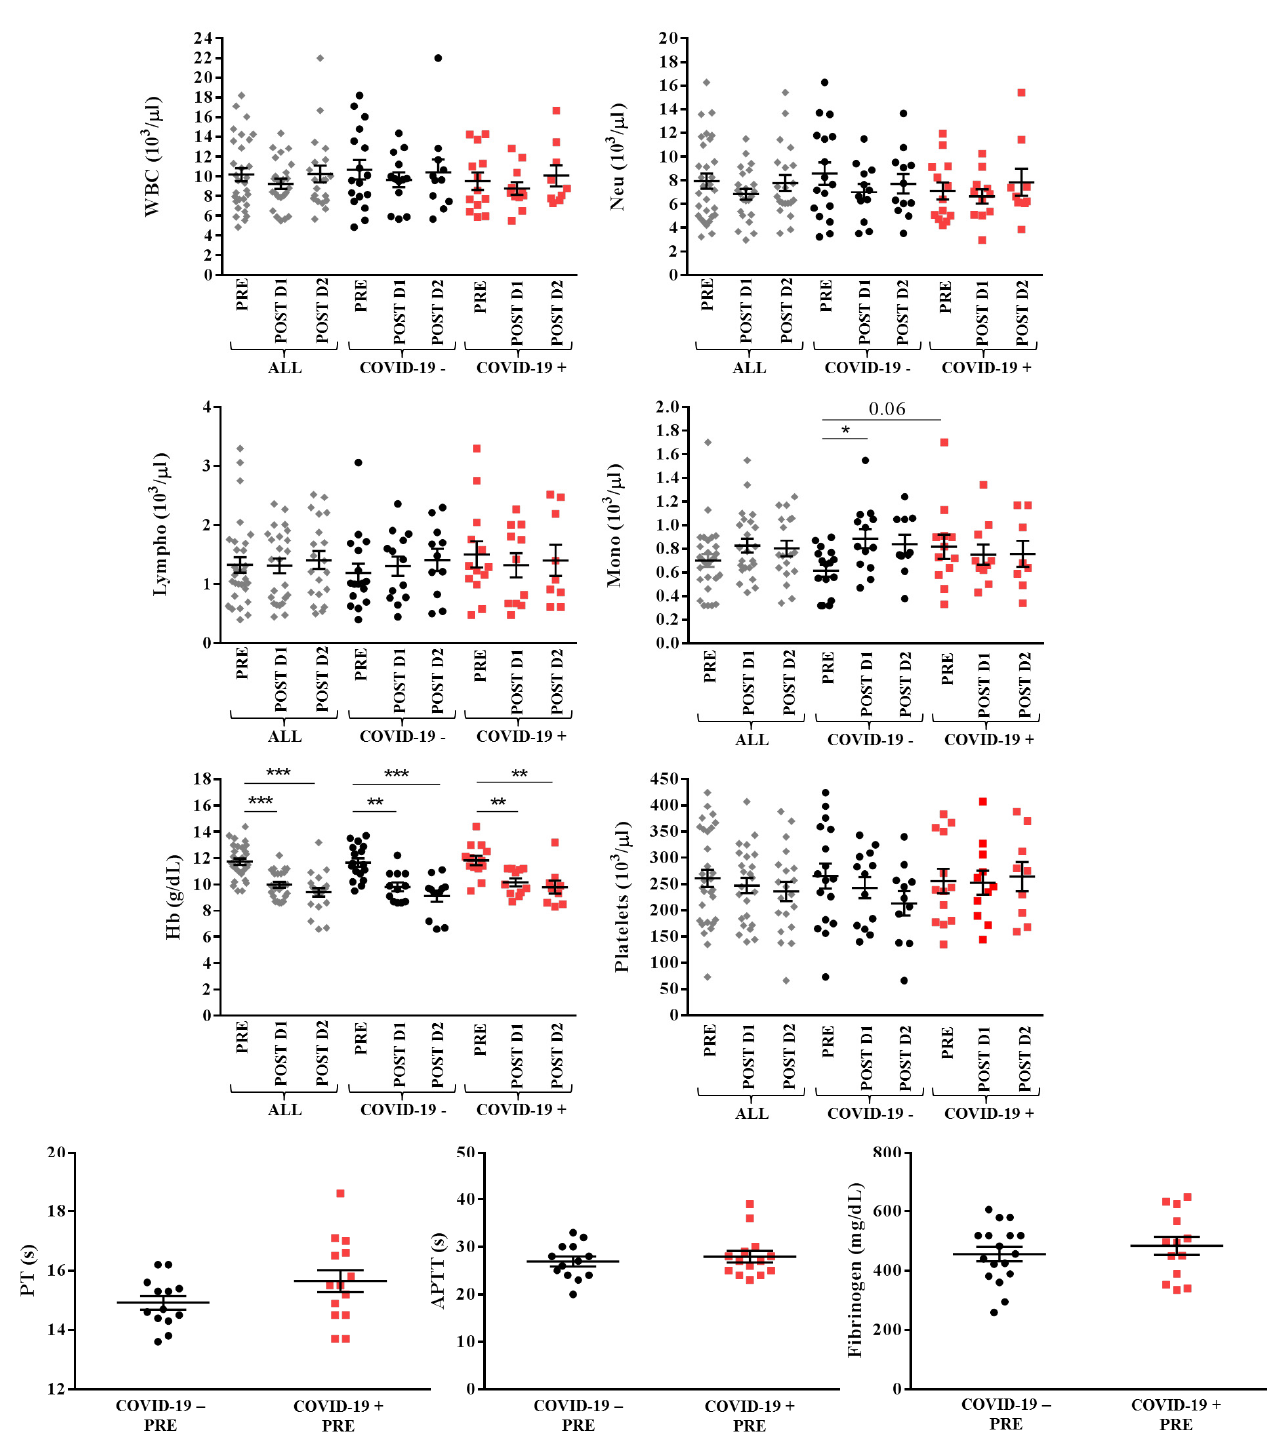
Figure 1. Hematological and coagulation parameters in overall (ALL, grey), COVID-19 − (black) and COVID-19 + (red) patients with lower limbs fractures registered pre- (PRE), day 1 (POST D1) and day 2 (POST D2) post-surgery. Mean with SEM are showed. * p ≤ 0.05, ** p < 0.02, *** p < 0.001.